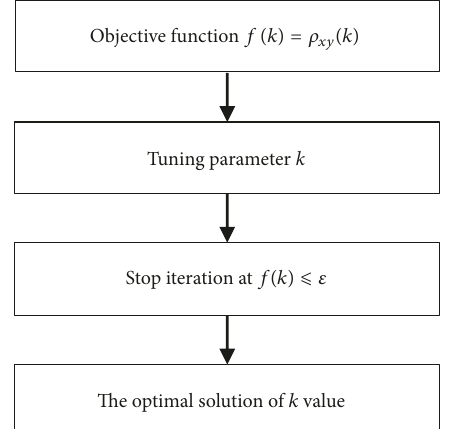
Figure 1: The algorithm block diagram of Newton’s method.